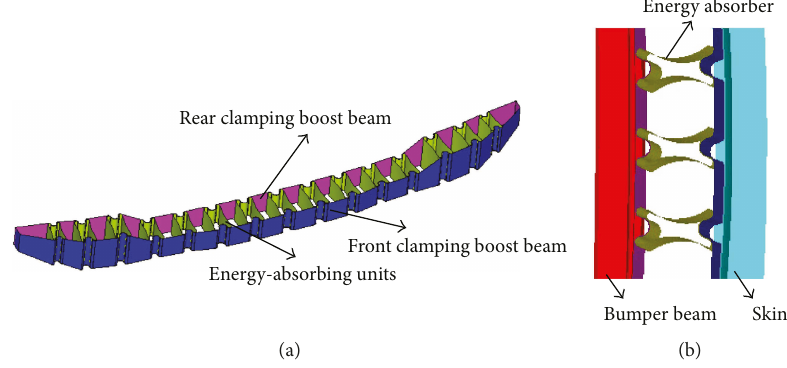
Figure 3: Schematic diagram of the (a) energy absorber and (b) installation position.